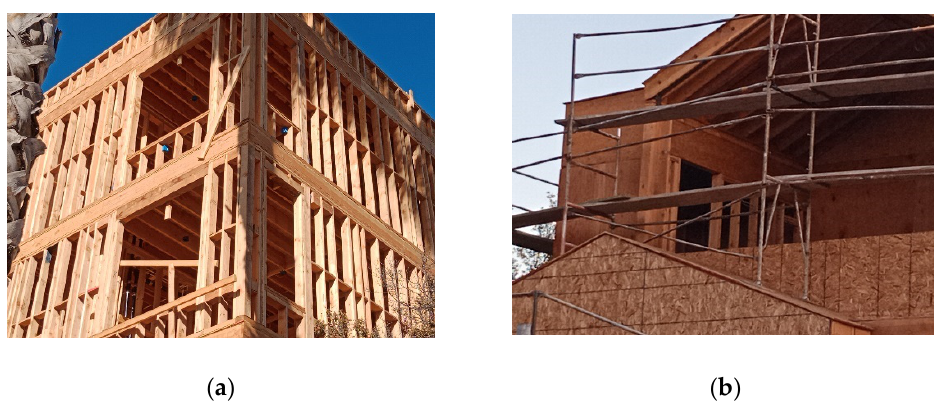
Figure 11. An example of a timber frame during the construction of a multi-family building (Los Angeles, California): ( a ) an example of a wooden skeleton.; ( b ) upholstery of the skeleton with fiber boards and further technological layers.